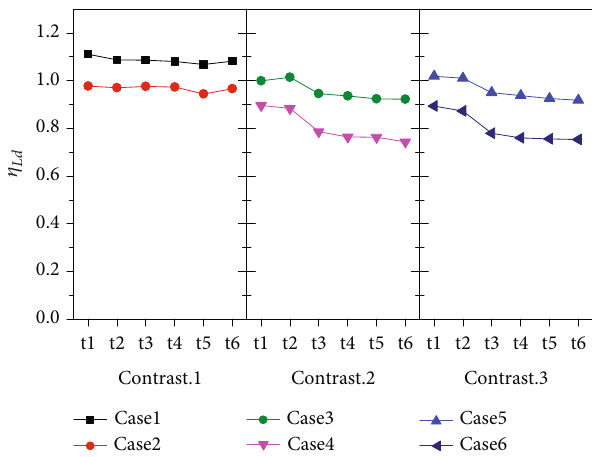
Figure 14: Comparative results of dimensionless icing inferior limits.